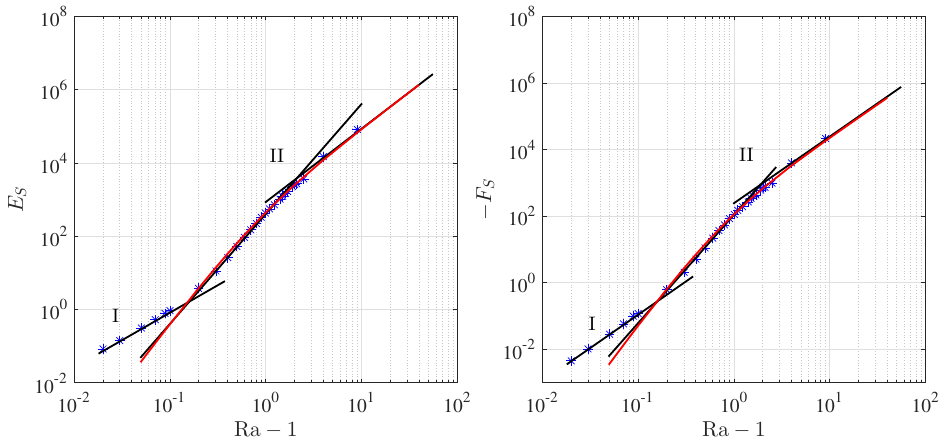
Figure 8. The dependence of E S and − F S on Ra in a log-log plot. Asterisks denote numerical results. The straight black lines have slopes of 1.5, 3 and 2 (left panel) and 2, 3.25 and 2 (right panel). The red curves are the predictions (49) and (50) valid in Regime